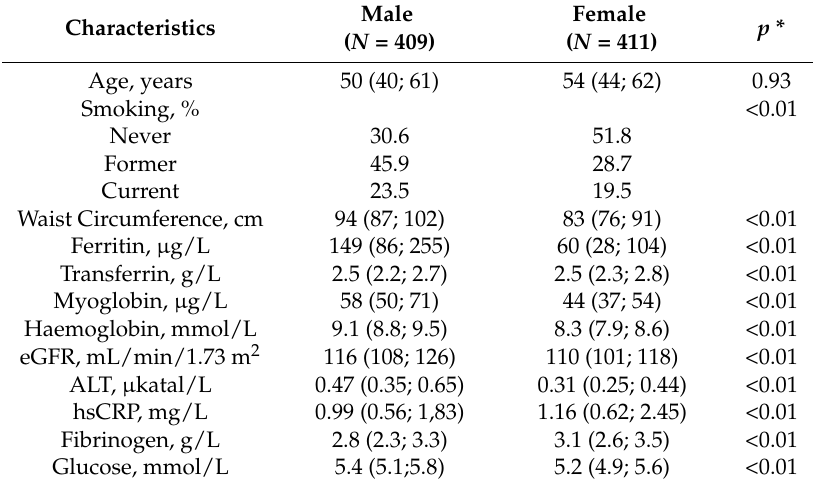
Table 1. General characteristics of the study